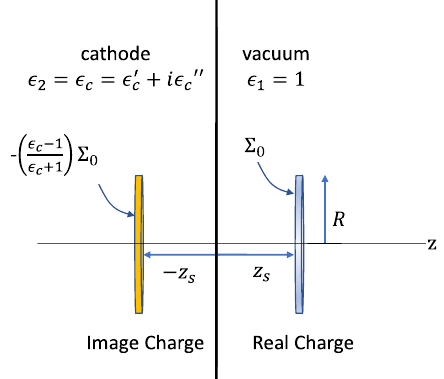
FIG. 4. The positions of a real disk of charge and its image with respect to the cathode surface.